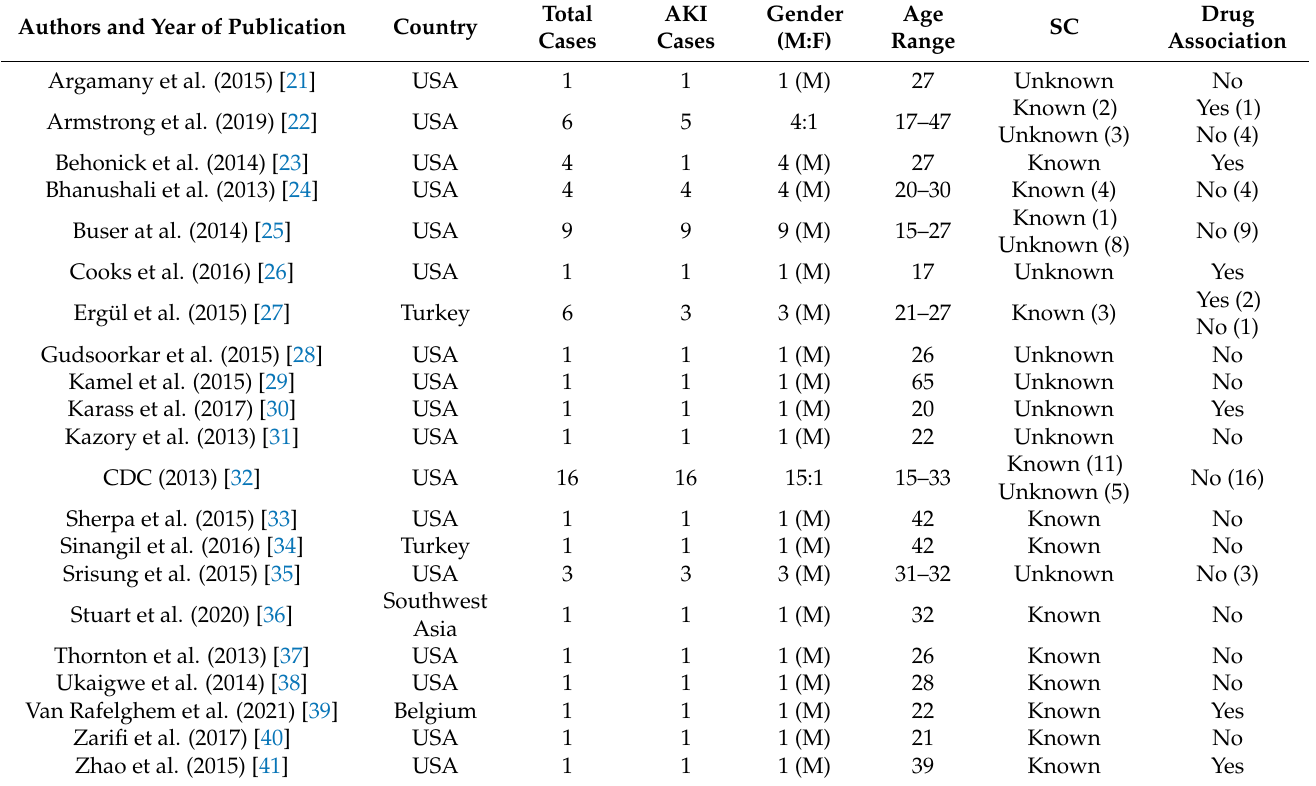
Table 1. Features of the primary studies